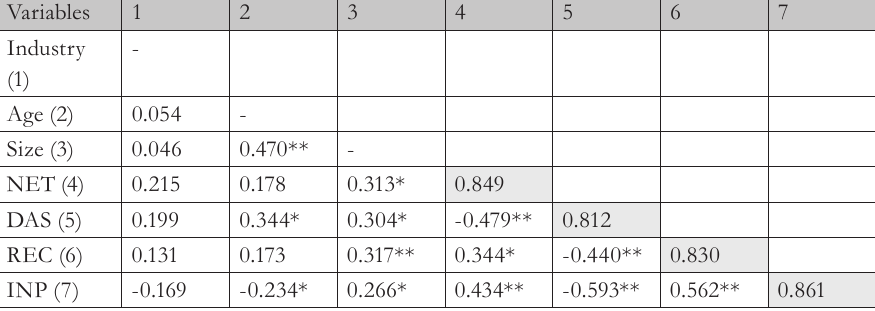
Tab. 3 – Discriminant validity and descriptive analysis. Source: own